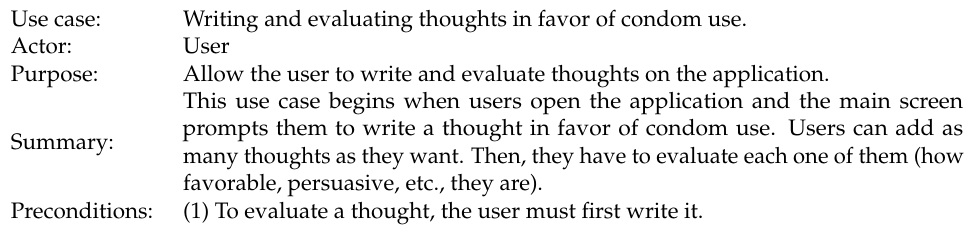
Table 1. General use case: writing and evaluating thoughts in favor of condom use.